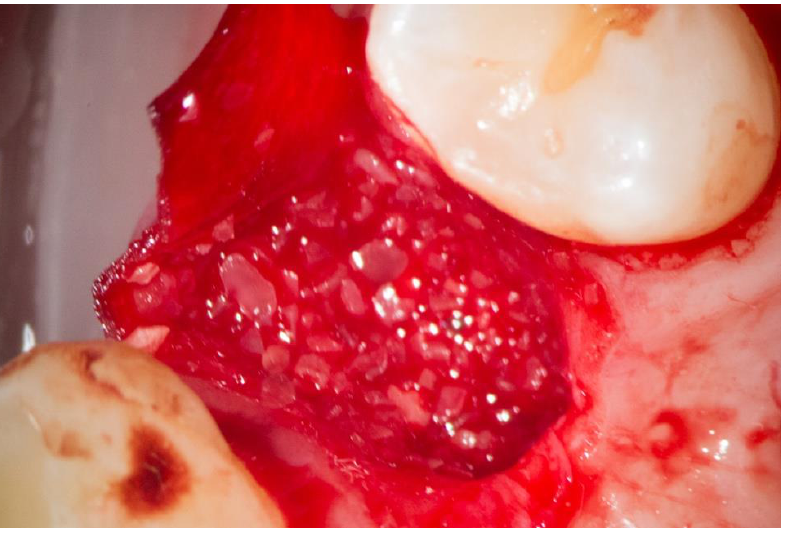
Figure 4. Collagen membrane and “sticky tooth” in